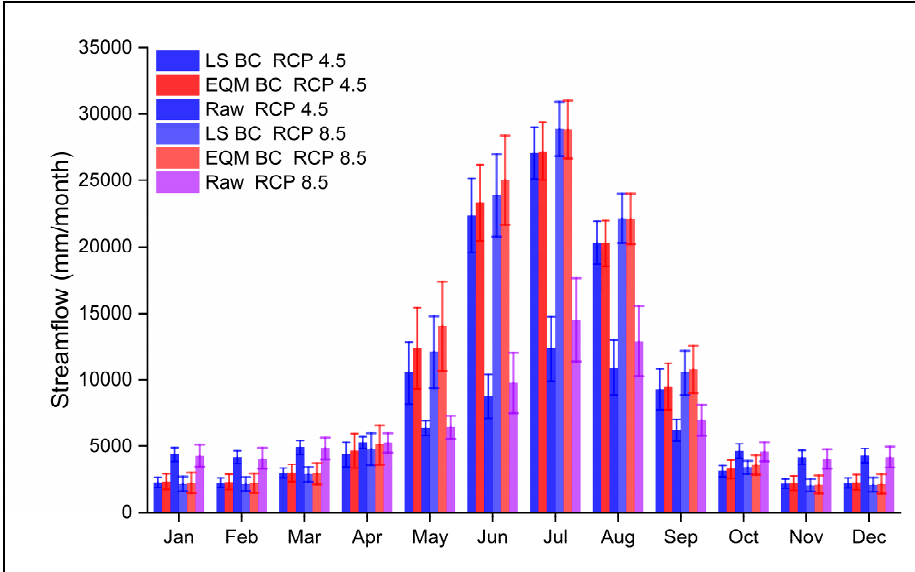
Figure 7. As Figure 5, but for mean monthly streamflow.